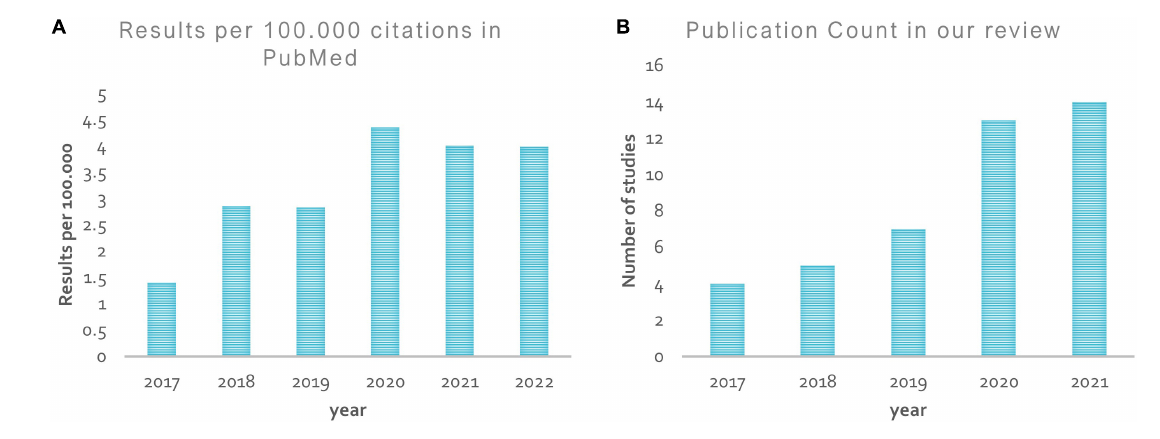
FIGURE8 Publication by year. (A) Shows a rise in the number of papers published in the ASD diagnosis area from 2017 onward, according to the “PubMed by year”; (B) represents the number of papers published, reviewed here, by